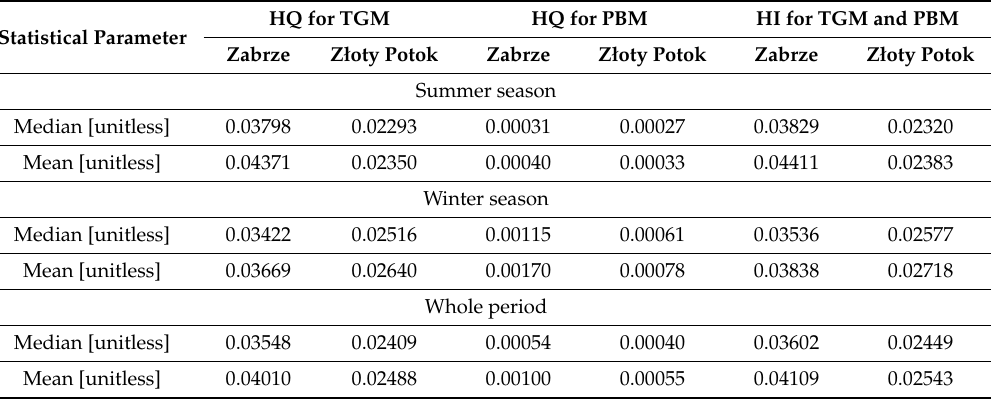
Table 5. The median and mean of hazard quotients (HQ) and hazard indexes (HI) for TGM and PBM concentrations in Zabrze and Złoty Potok (2014–2015) and the proposal of revised EPA’s reference concentration RfC R = 0.07 µ gm − 3 .